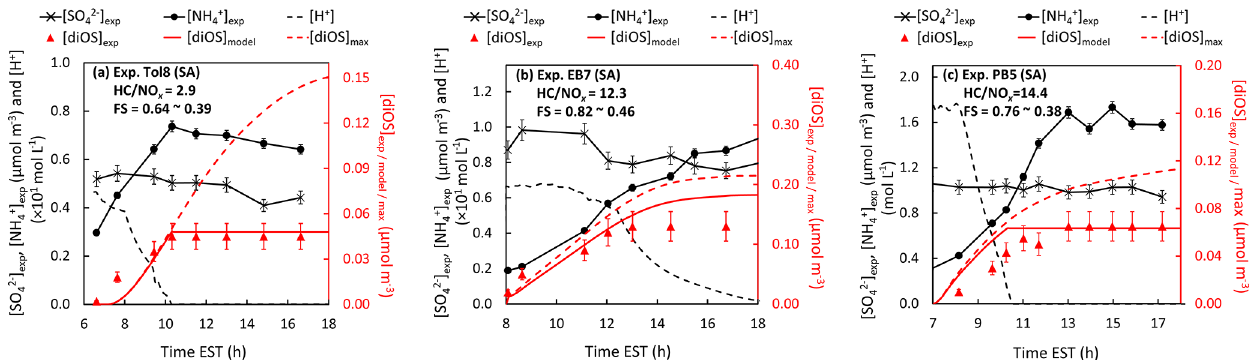
Figure 5. Time profiles of measured inorganic sulfate concentration ([SO 2 − ] exp ), ammonium concentration ([NH + ] exp ), diOS concen- 4 4 tration ([diOS] exp ), the predicted proton concentration ([H + ]), diOS concentration ([diOS] model ), and the maximum diOS concentration ([diOS] max ) (assuming there is no ammonia neutralization in the system) for SOA generated from (a) toluene (Exp. Tol8, HC / NO x = 2.9, OM-to-sulfate mass ratio (OM:sulf) = 1.4), (b) ethylbenzene (Exp. EB7, HC / NO x = 12.3, OM:sulf = 1.4), and (c) n -propylbenzene (Exp. PB5, HC / NO x = 14.4, OM:sulf = 0.7). The degree of neutralization is indicated by FS, ranging from 1 (for sulfuric acid) to 0.33 (for ammonium sulfate). “SA” stands for experiment with direct-injection sulfuric-acid-seeded aerosols. The ions and diOS concentrations were corrected for the particle loss to the chamber wall. The experimental conditions are available in Table 1.